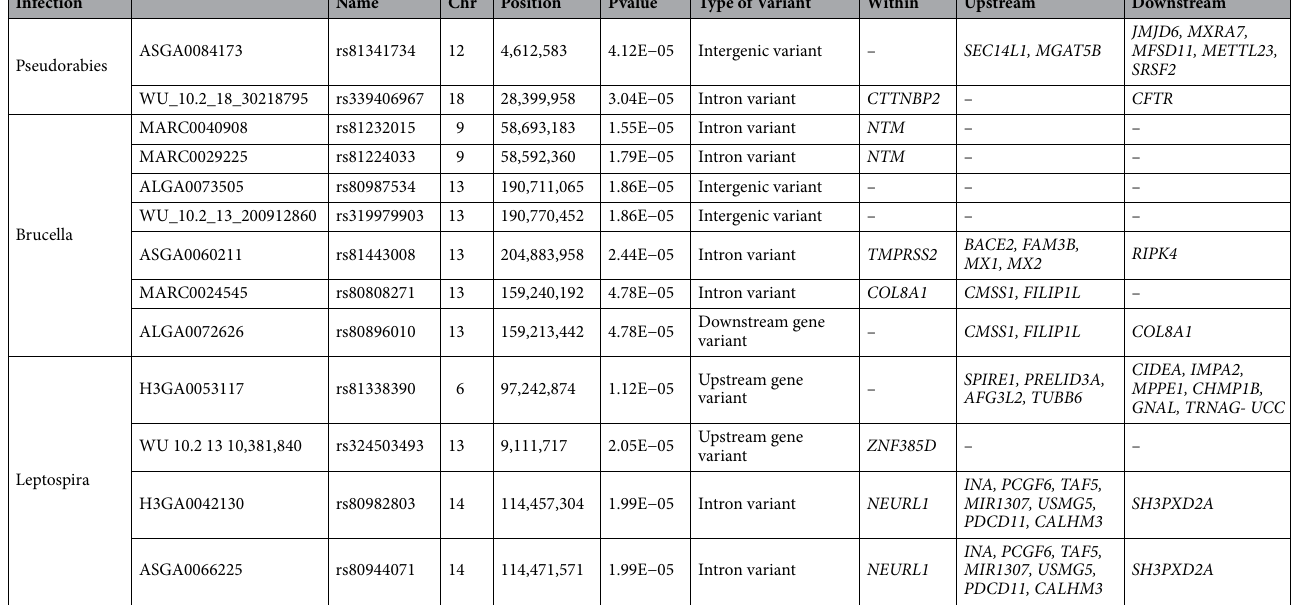
Table 2. List of significant SNPs identified for each disease. The SNP name, the chromosome and pb positions, p-value, type of variant and the list of the candidate genes in the regions flanking the significant markers (± 250,000 nucleotides) are reported.